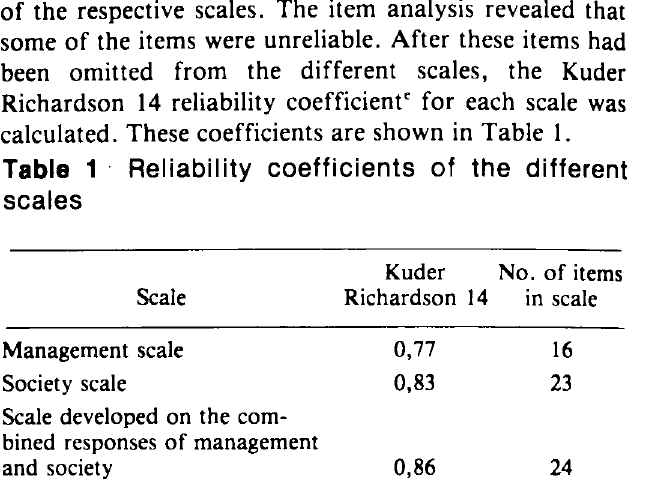
Table 1 · Reliability coefficients of the different